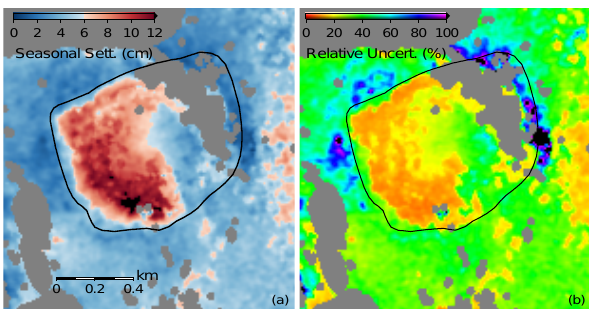
Fig. 4. (a) Average seasonal thaw settlement for 2006–2010 and (b) relative uncertainties in SAC basin and the surrounding tundra area. The black line shows the basin boundary, defined by the shore- line prior to drainage. Low coherence areas are masked out in